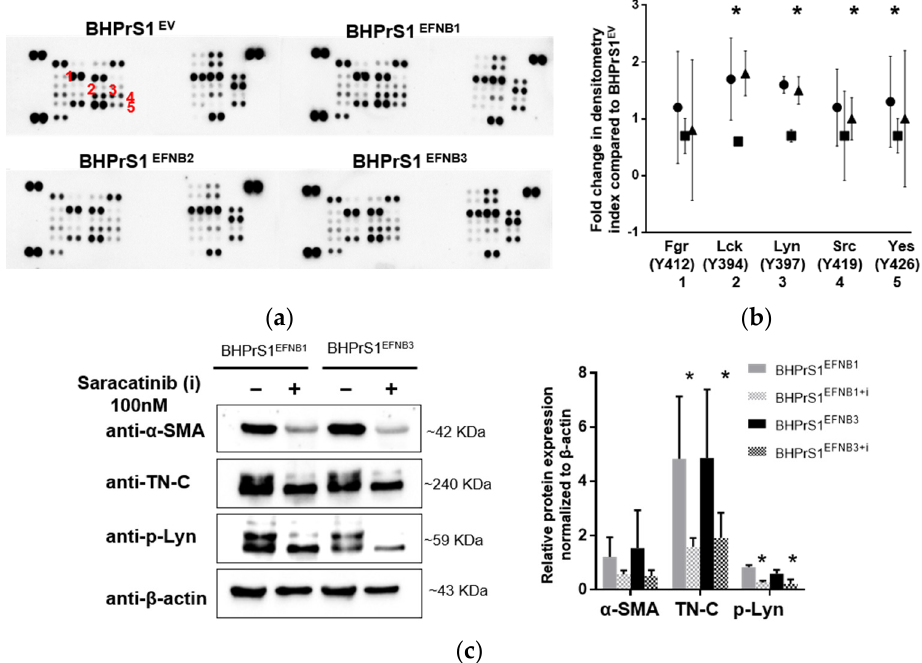
Figure 6. Ephrin ligands expression activates Src family kinases (SFK) in stromal cells. ( a ) Phospho- kinase array in control and EFNB ligands overexpressed BHPrS1 cells revealed overexpression of Src family kinases (SFK) in BHPrS1 EFNB1 and BHPrS1 EFNB3 compared to BHPrS1 EV .Densitometry anal- ysis of SFK phospho-protein arrays show marked phosphorylation of SFK family members Fgr (1), Lck (2), Lyn (3), Src (4) and Yes (5). ( b ). Data are presented as fold changes of BHPrS1 EFNB1 (circles), BHPrS1 EFNB2 (squares), and BHPrS1 EFNB3 (triangles) compared to controls (BHPrS1 EV ) (tr = 2, * p < 0.05). ( c ) Both BHPrS1 EFNB1 and BHPrS1 EFNB3 were treated with Saracatinib (100 nM) for 48 h to inhibit SFK activation. After Saracatinib exposure, α -SMA (alpha smooth muscle actin) and TN-C (Tenascin C) expression in BHPrS1 EFNB1 and BHPrS1 EFNB3 cell lines went down (Left). p -Lyn, α -SMA and TN-C expressions were quantified and normalized to β -actin (Right). Data is presented as mean of three independent biological experiments (* p < 0.05). 3.8. Inhibition of SFK Suppressed CAF Activation In Vitro SFKs are involved in the pathogenesis of several cancers, including PCa [47–49], and activation of fibroblasts in different organs [43–46]. The Src inhibitor Saracatinib (AZD0530) has been shown to have antitumor activities in cancer cells and is currently being evaluated in a Phase 1b/2a clinical trial for the treatment of Idiopathic Pulmonary Fibrosis (NCT04598919). Both in vitro and in vivo studies show that inhibition of SFK blocks the activation of fibroblasts [43]. We used Saracatinib (AZD0530) to block Src fam- ily kinases to determine whether SFK phosphorylation is involved in CAF activation in EFNB1- and EFNB3- expressing BHPrS1 cells. We inhibited SFK using Saracatinib at 100 nM and evaluated the phosphorylation of Src (Y419), Lck (Y394), and Lyn (Y397). We tested different time points for Saracatinib-induced inhibition of SFK phosphorylation and found decreased phosphorylation (Src Y419, Lck Y394, and Lyn Y397) levels after 60 min (Figure S5a,b). After 48 h of treatment with Saracatinib, we isolated protein from BHPrS1 EFNB1 and BHPrS1 EFNB3 cells and assessed the expression of CAF markers. At 100 nM concentration, Saracatinib effectively reduced the expression of α -SMA and TN-C in both BHPrS1 EFNB1 and BHPrS1 EFNB3 fibroblasts (Figure 6c). A slight decrease in α -SMA ex- pression was noted in BHPrS1 EV cells upon saracatinib inhibition (Figure S5c). Taken to- gether, these data points suggest that Saracatinib blocked the activation of SFK and pre- vented EFNB1/3-induced expression of CAF markers ɑ -SMA and TN-C in vitro. 4. Discussion